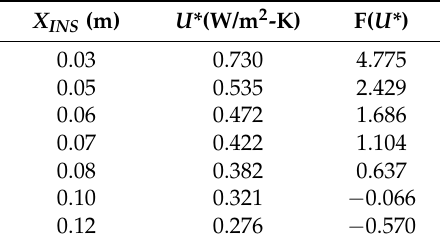
Table 6. Trial and error method to find optimum thermal transmittance U* .